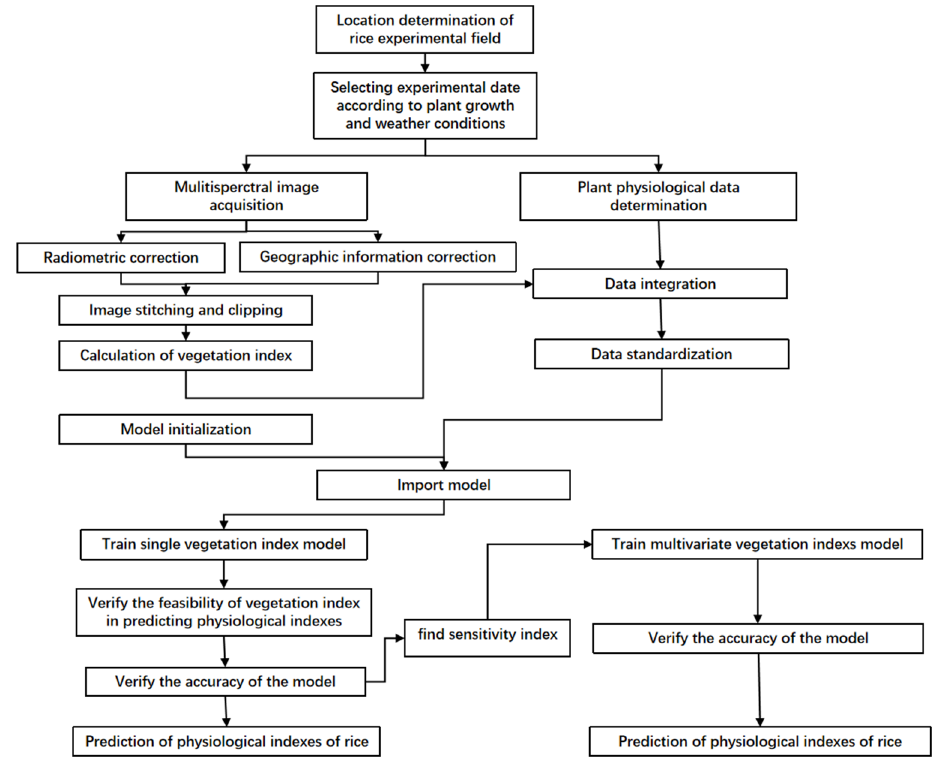
Figure 3. Framework of multispectral mode.